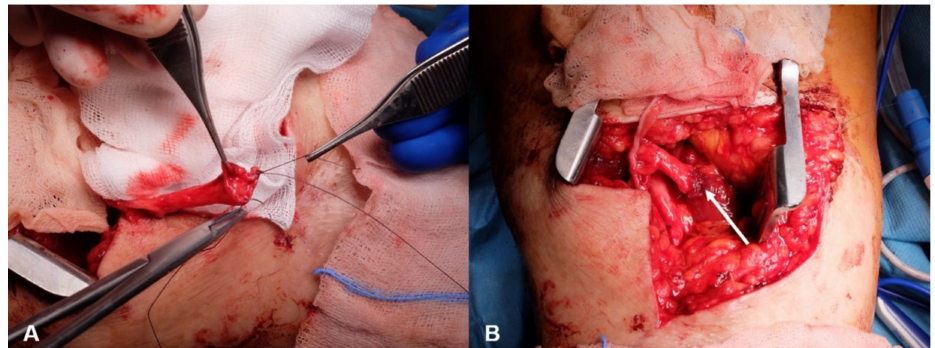
Figure 1. Prevention of neuroma recurrence: ( A ) nerve stump covering with an epineural cap; ( B ) transposition of this nerve stump into muscle